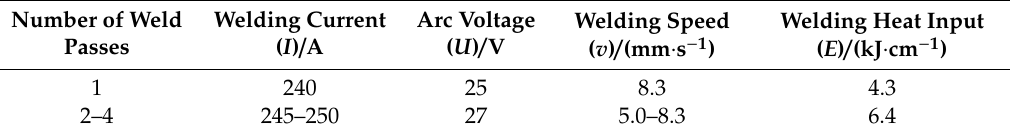
Table 2. Welding process